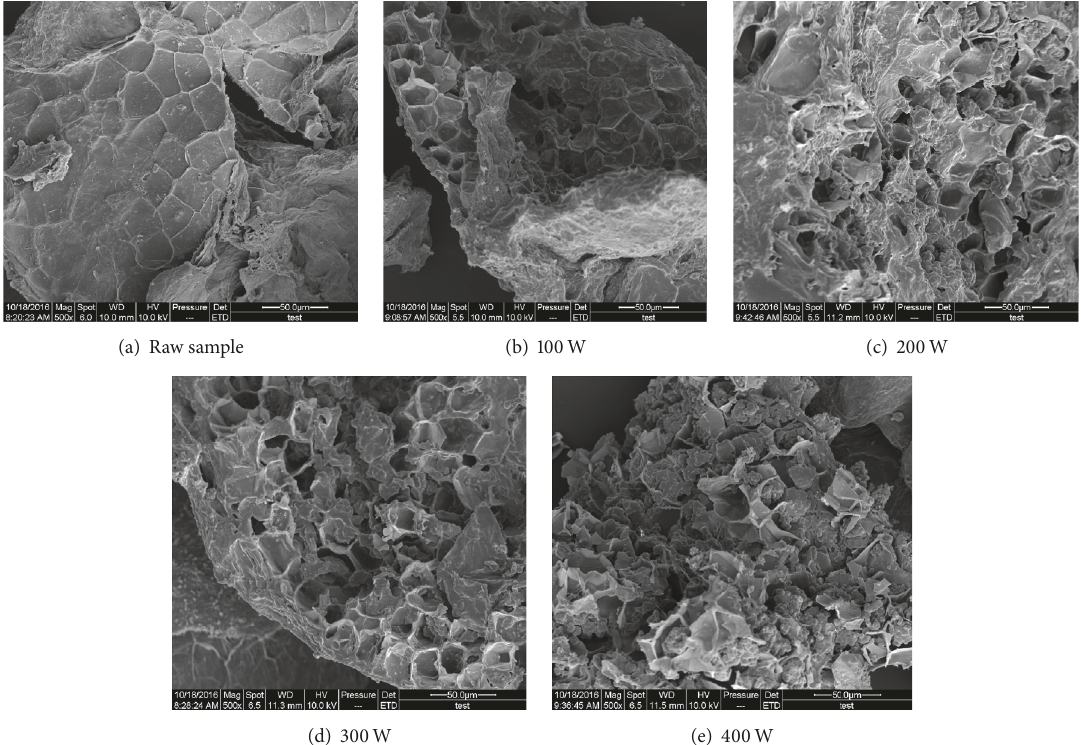
Figure 9: Microstructure of blueberry powder of raw sample and those extracted by microwave powers.